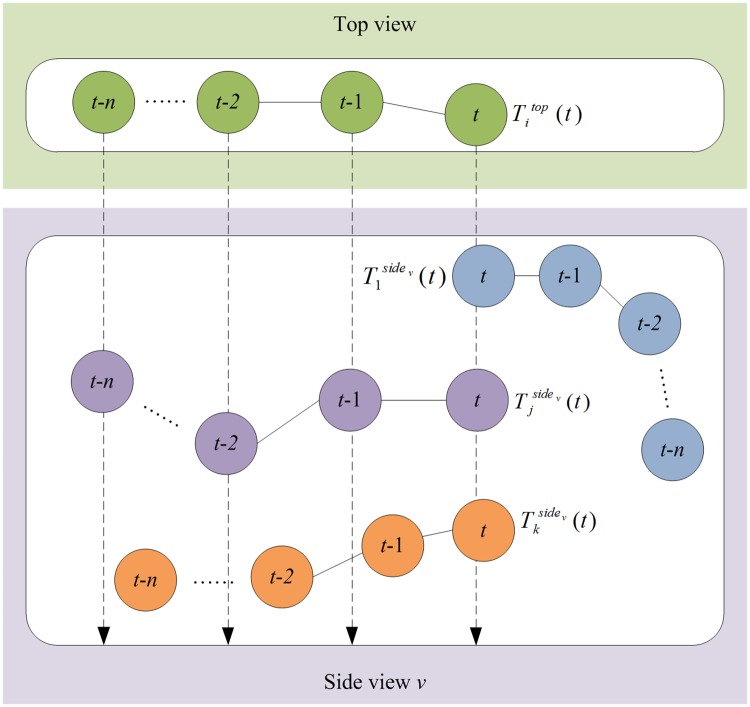
Example of stereo matching.The dashed arrows indicate the epipolar lines. An object in the top view can find k candidates on corresponding epipolar line at frame t. The matching object is determined by the maximum matching length of two trajectories under the epipolar constraint.